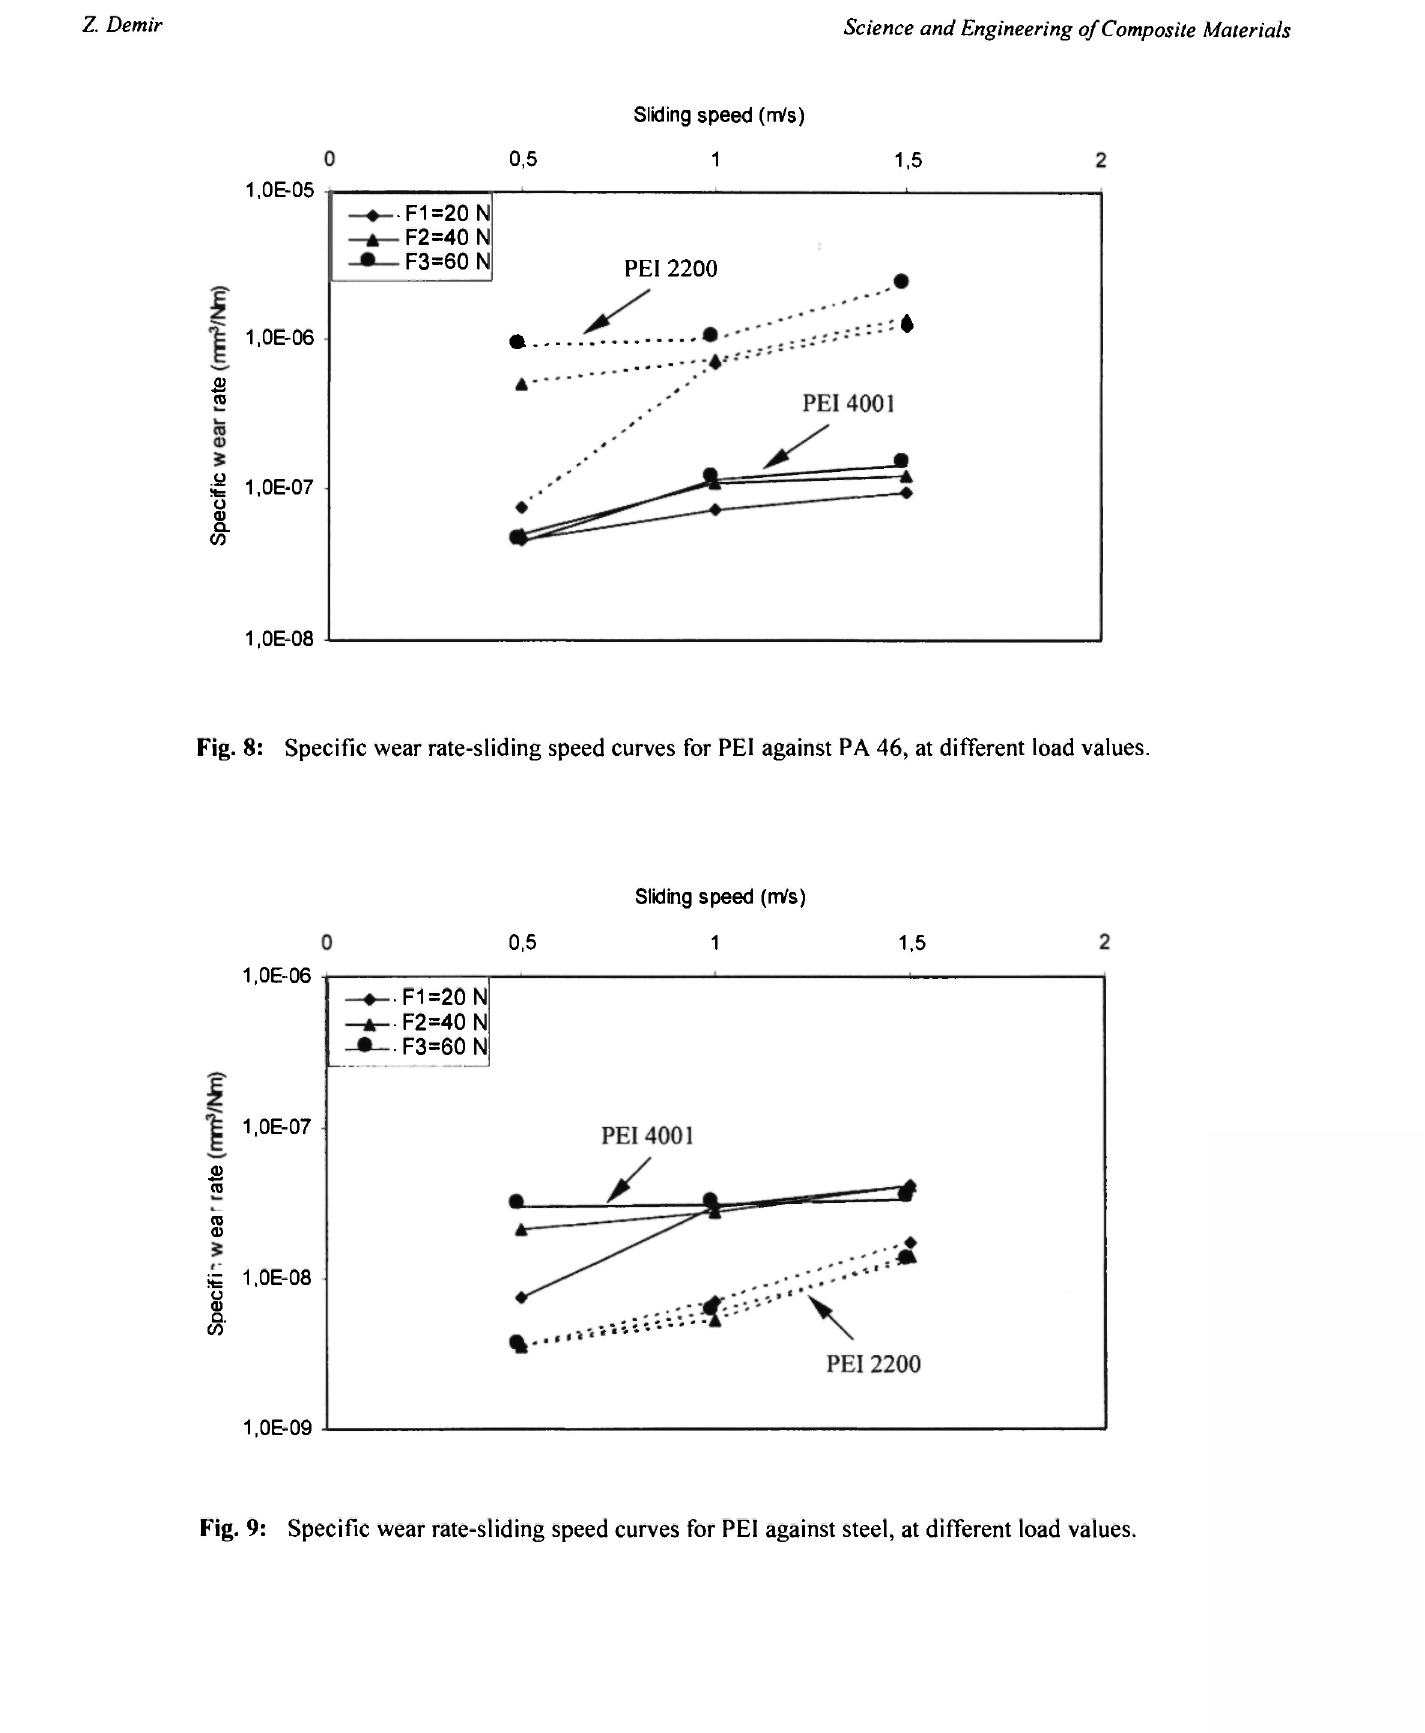
Fig. 9: Specific wear rate-sliding speed curves for PEI against steel, at different load